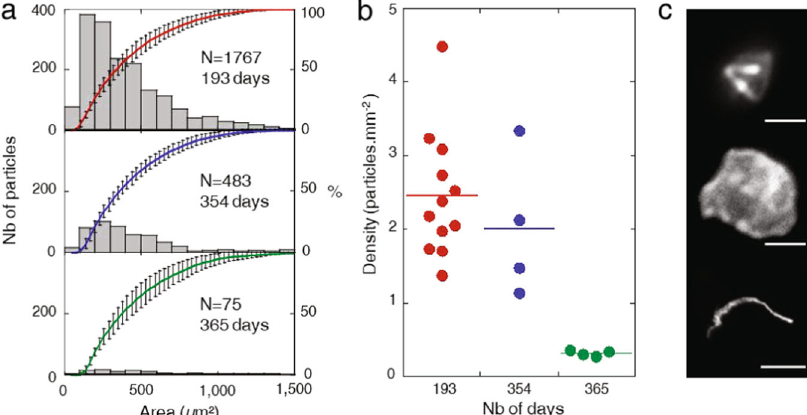
Fig. 1 Surface contamination kinetics by coarse particles (50 < Area < 1500µm 2 ) on FDTS coating. a Particle size distribution histogram (grey bars) versus the area in μ m² and cumulative particle size curves after MATISS-1 (193 days of exposure (red)), MATISS-2 (354 days (blue)) and MATISS-2.5 (365 days (green)) campaigns. Each holder has its symbol. Error bars represent the standard deviation of the data. b Dot-plots showing the density values of the coarse particles measured on surfaces of 8 x 8 mm. Centerlines show mean values: 2.45 ± 0.81 for MATISS-1 (193 days), 2.01 ± 0.84 for MATISS-2 (354 days) and 0.36 ± 0.12 for MATISS-2.5 (365 days). c Mosaic of optical images recorded at low magni fi cation displaying typical shapes of coarse particles (top and middle, scale bar is 10 μ m) and macroscopic particles (area > 1500 μ m², bottom, scale bar is 100 μ